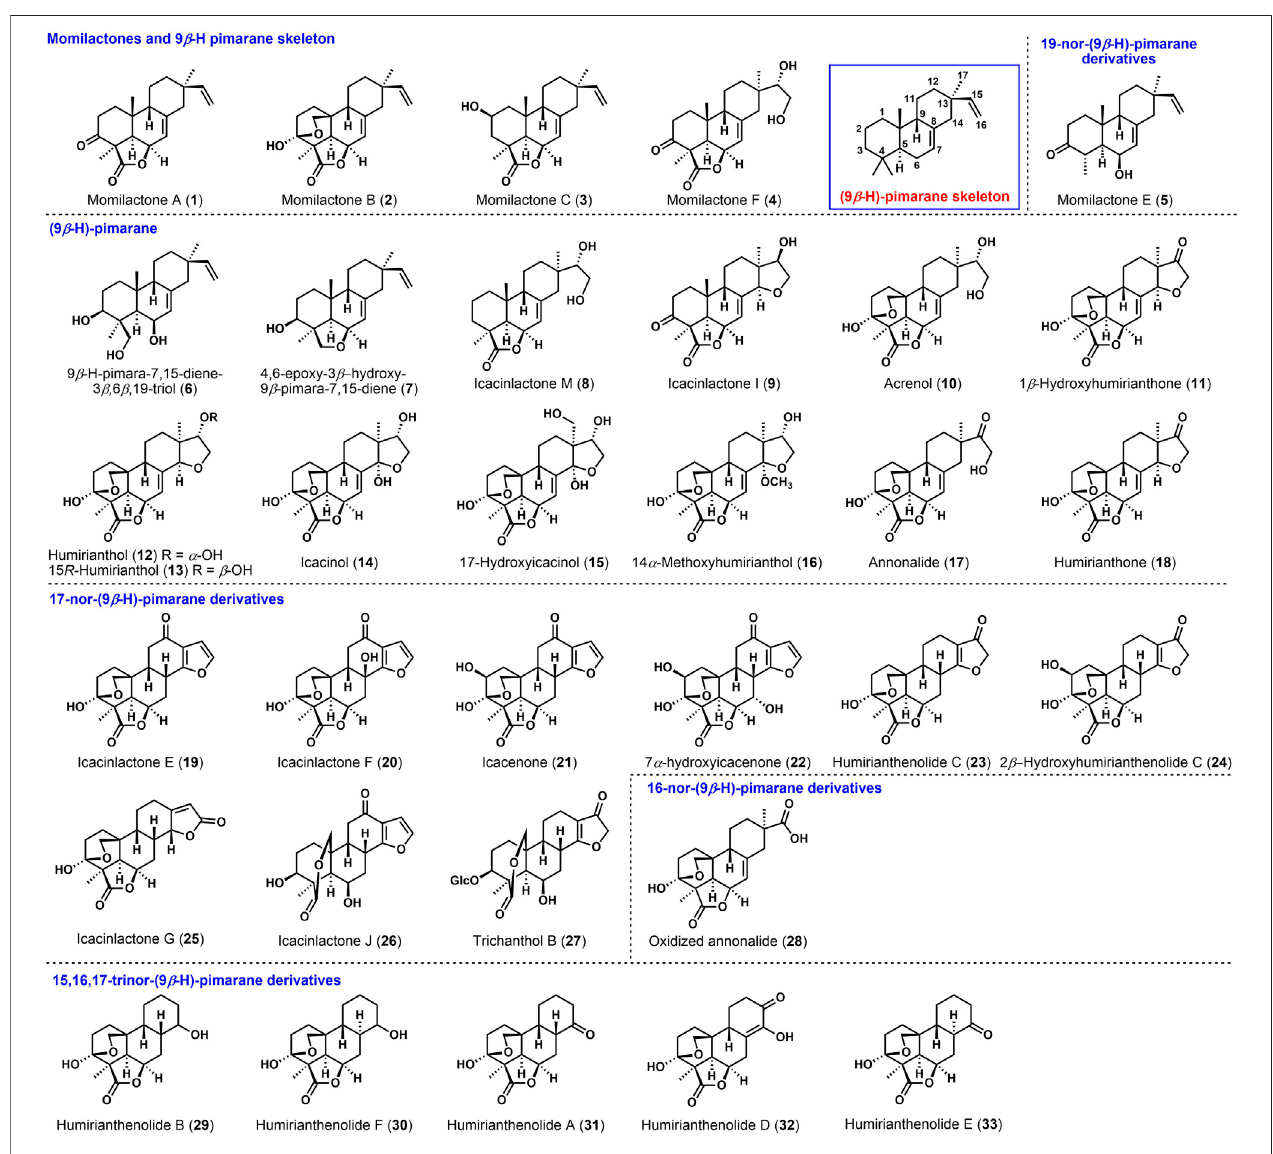
FIGURE 1 | 9 β -H-Pimarane related diterpenoids and the 9 β -H pimarane skeleton.